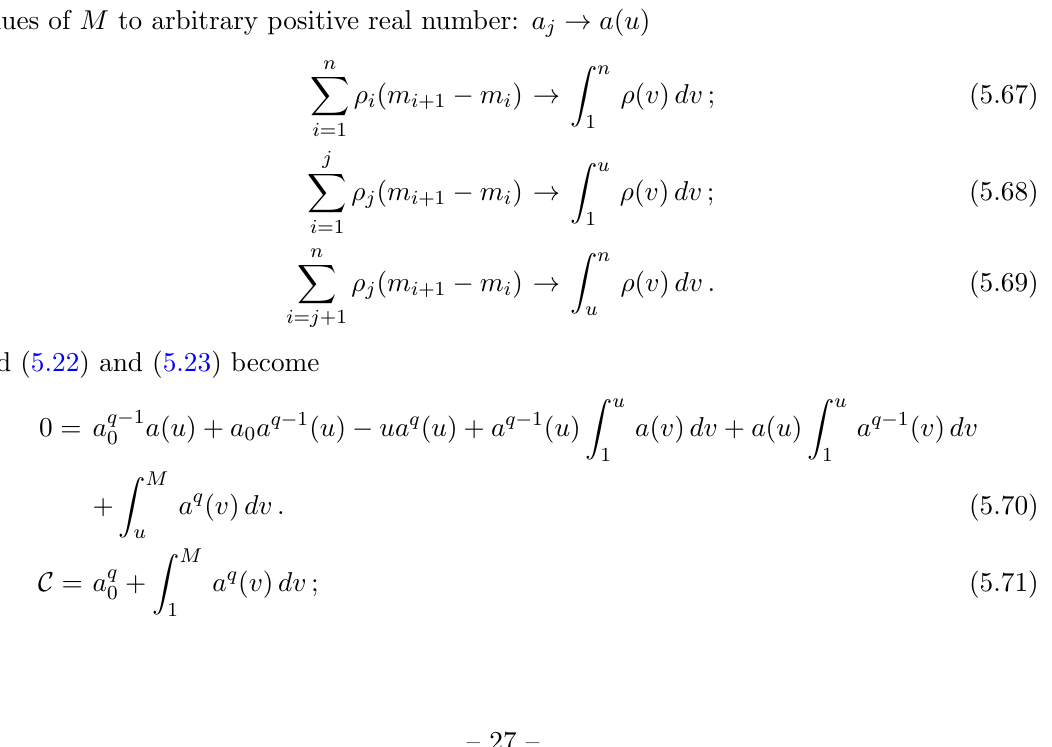
Figure 6 . (a) Regularized free energy on replica-symmetric saddles at various values of q . (b) Free energy of the lowest replica-symmetric saddle as a function of q